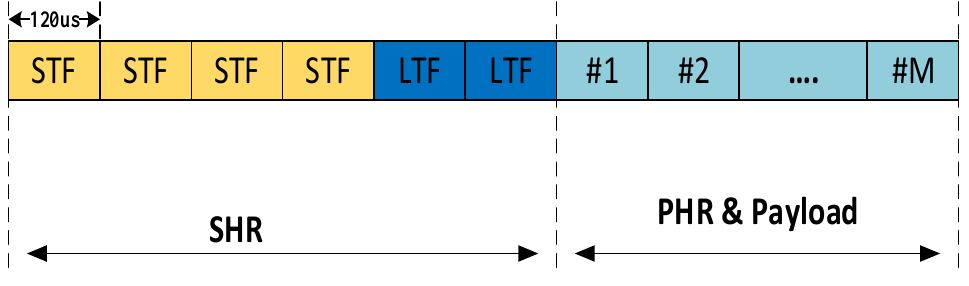
Figure 2. Structure of a packet. Table 1. Data rates for IEEE 802.15.4g SUN MR-OFDM [10].